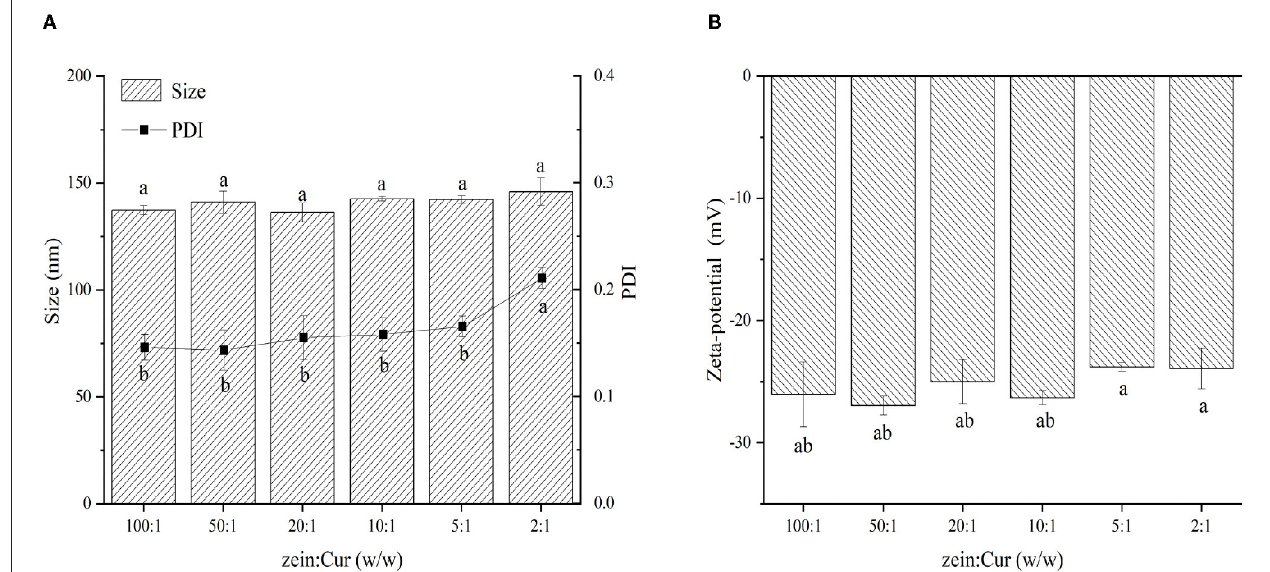
FIGURE 1 | The effect of mass ratio of zein to GA (A,B) on the hydration diameter, polydispersity index (PDI), and zeta-potential of ZGT-Cur composite nanoparticles. Different small letters indicate a significant difference ( p < 0.05), the same below.